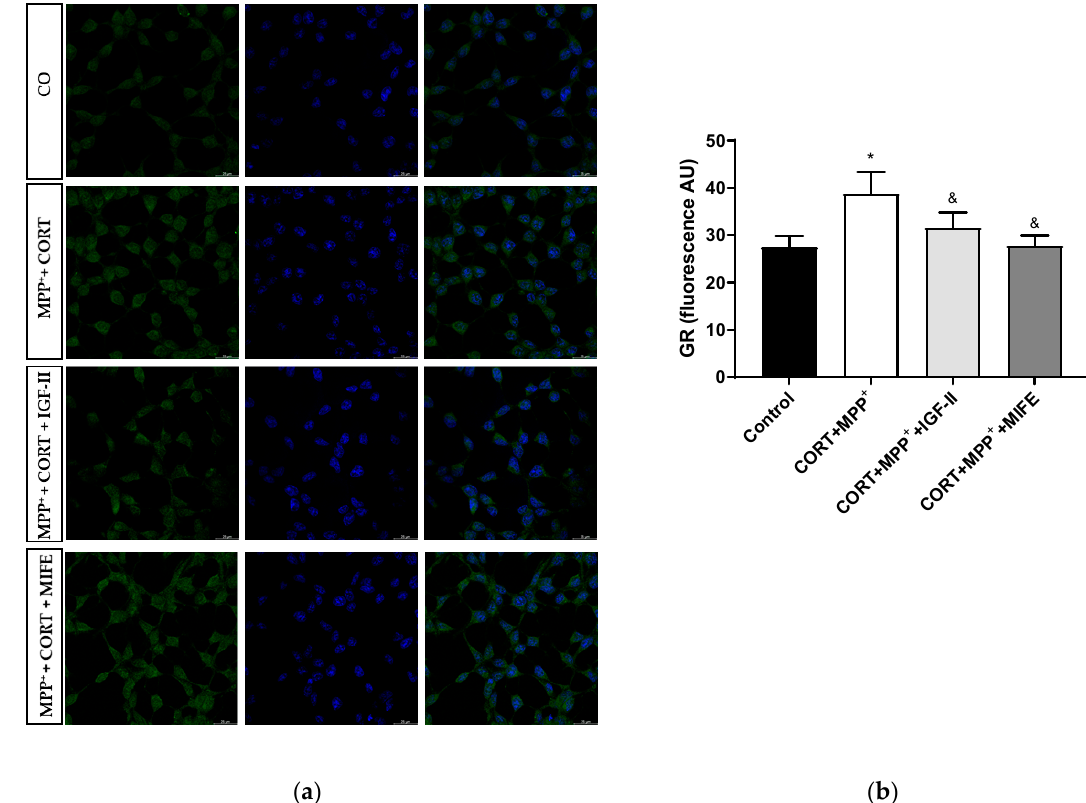
Figure 8. Study of GR expression in SN4741 neuronal cells after 2.5 h of incubation with the combination of corticosterone and MPP + (CORT + MPP + ) in the presence or absence of IGF-II. ( a ) Representative immunocytochemistry stain for DAPI and GR (63X). CO: control cells; ( b ) Quantification of GR immunofluorescence. Fluorescent intensity was estimated by number of cells per field. Data from three independent experiments were combined and presented as mean ± SEM. * p < 0.05 compared to control cells; & p < 0.05 compared to CORT + MPP + co-incubated cells.